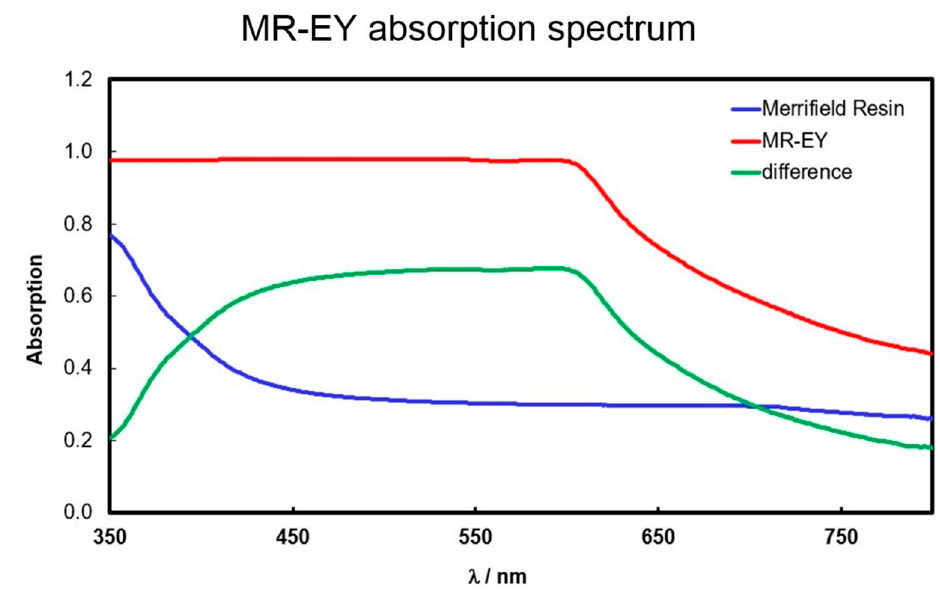
Figure 1. UV-vis absorption spectra of MR-EY, Merrifield resin and difference.